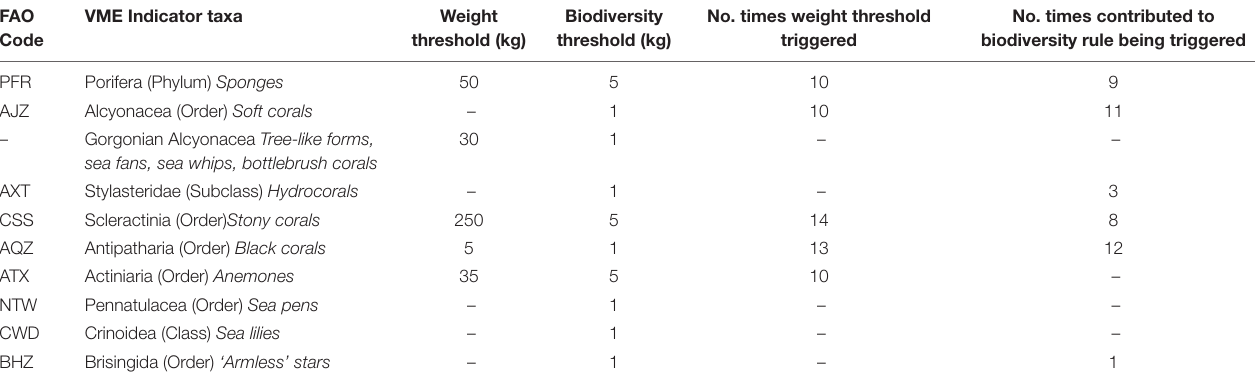
TABLE 4 | Single-taxon thresholds for a move-on rule, and number of times thresholds triggered by 9,771 historic trawls had the move-on rule been in place. FAO